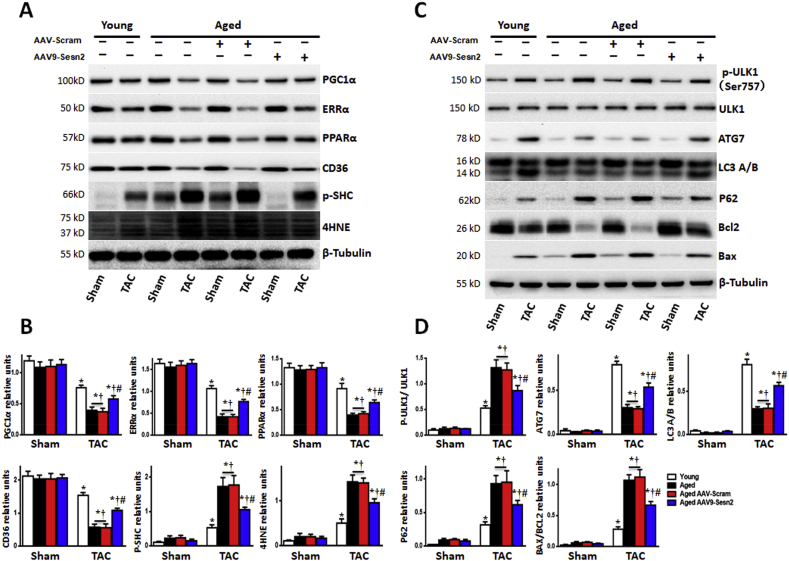
Sesn2 rescue in aged hearts improves myocardial metabolism and autophagy response to pressure overload. (A) Immunoblot for proteins in metabolic regulatory pathways from hearts of aged WT (Aged) mice and young WT (Young) mice at 4 weeks after TAC or sham surgery. (B) Quantification of relative expression levels of indicated proteins (n = 5–6 per group). (C) Immunoblot for indicated autophagy-related indicated proteins from hearts of aged WT and young WT mice at 4 weeks after TAC or sham surgery. (D) Quantification of relative expression levels of indicated proteins (n = 5–6 per group). Values are mean ± SEM, *p < 0.05 vs. Sham group; #p < 0.05 vs. corresponding young WT group; †p < 0.05 vs. corresponding Y-Sesn2 KO group.